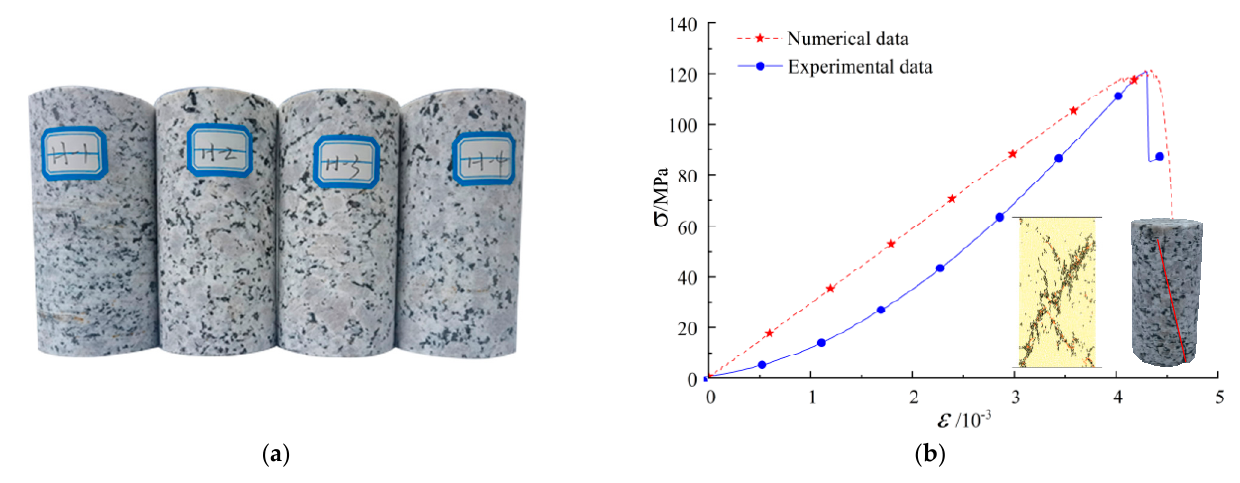
Figure 2. Laboratory test and numerical simulation. ( a ) Rock specimens ( b ) Numerical simulation results. Table 1. Uniaxial compression test results.